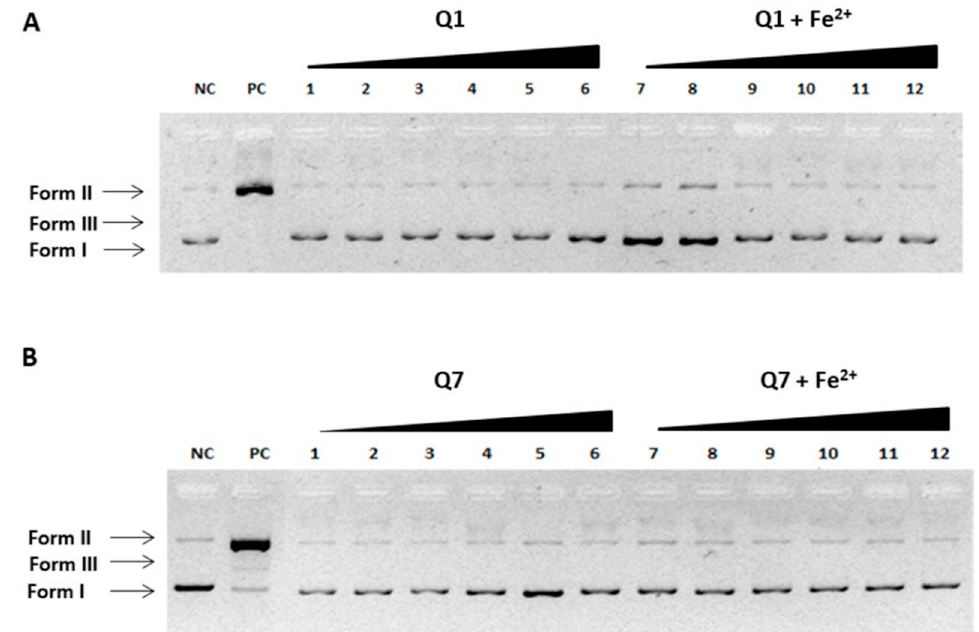
Figure 1. Electrophoretic monitoring of topological changes induced in the structure of plasmid DNA (pBR322) with compounds Q1 ( A ) and Q7 ( B ). Plasmid DNA treated only with Q1 and Q7 in selected concentrations (5, 10, 20, 50, 100, 500 µM) (lanes 1 – 6); treatment with increasing concentrations (5 – 500 µM) of Q1 and Q7 in the presence of Fe 2+ ions (lanes 7 – 12); negative control (NC): intact plasmid pBR322; positive control (PC): pBR322 treated with Fe 2+ ions. Treatment of pBR322 with Fe 2+ ion-induced DNA breaks resulting in conversion of the plasmid topology from the supercoiled (form I) to single-strand breaks (form II) or double-strand breaks (form III).